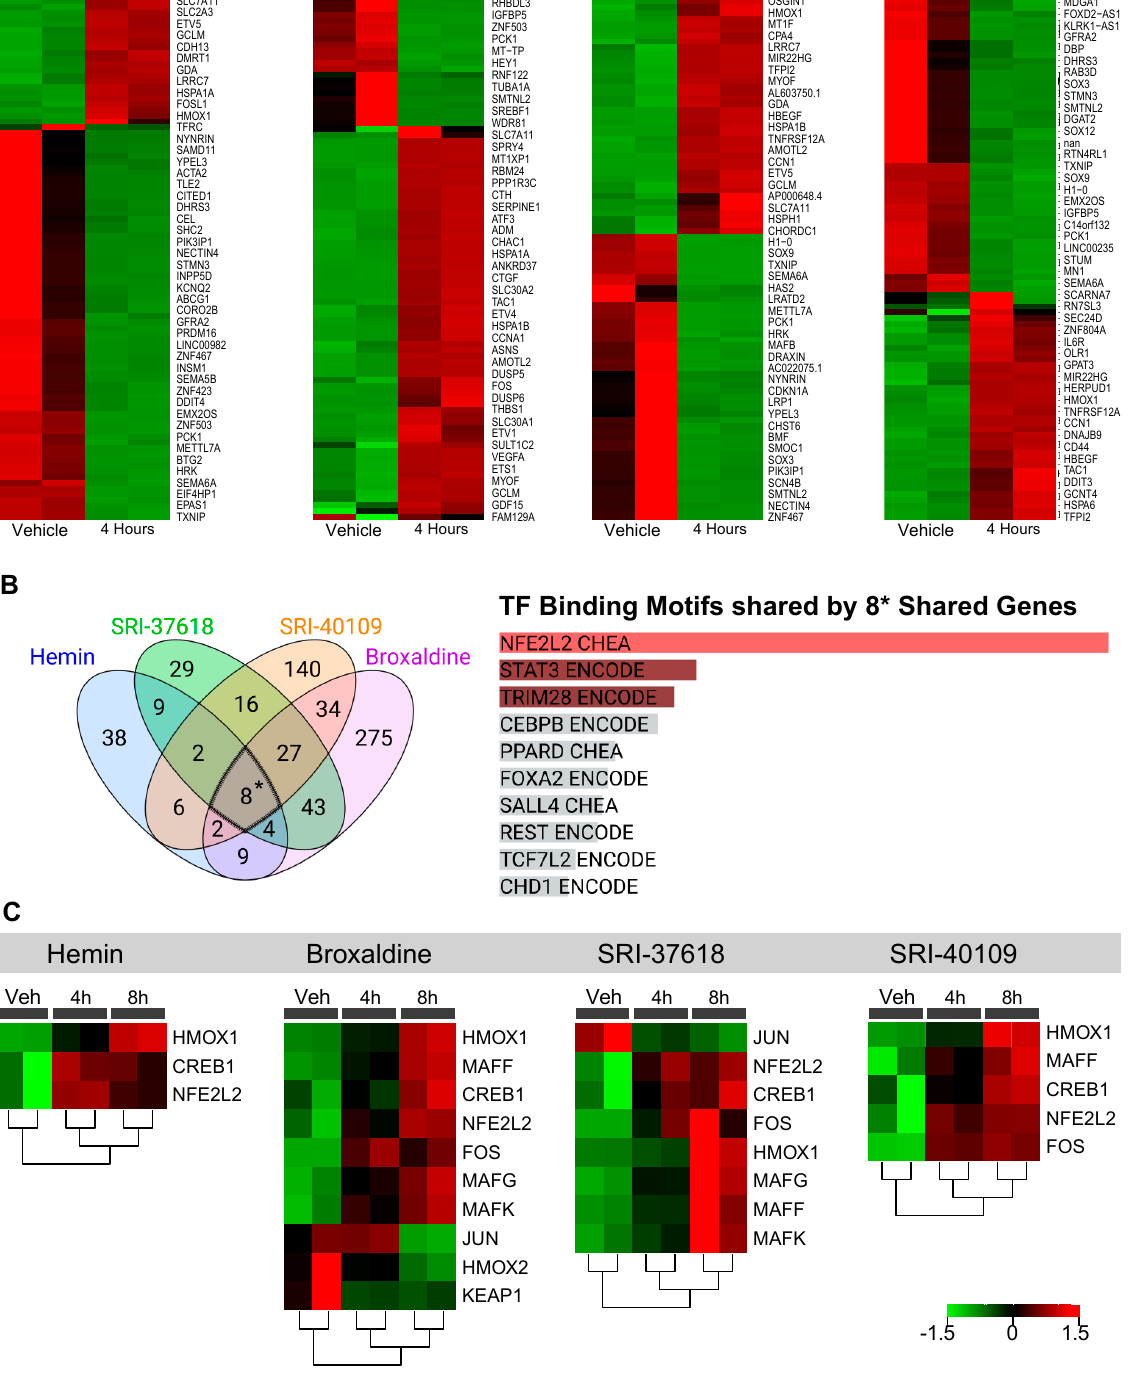
Figure 5. ( A ) Heatmap of the top 100 differentially expressed genes in HEK293 cells exposed to hemin, broxaldine, SRI − 37618, or SRI − 40109 for 4 h. Red coloration depicts genes upregulated, and green depicts genes downregulated relative to vehicle control. ( B ) Left panel: Venn diagram displaying the number of shared genes upregulated at 4 h by all four treatment conditions relative to vehicle control. * Eight shared genes upregulated at 4 h: CPNE9 , GCLM , GCNT4 , HMOX1 , SLC7A11 , SERPINE1 , OSGIN1 , and NMRAL2P . Right panel: Enrichr analysis for eight shared genes showing top 10 consensus transcription factor-binding sites from ENCODE and ChEA ChIP-X. Bar graph is